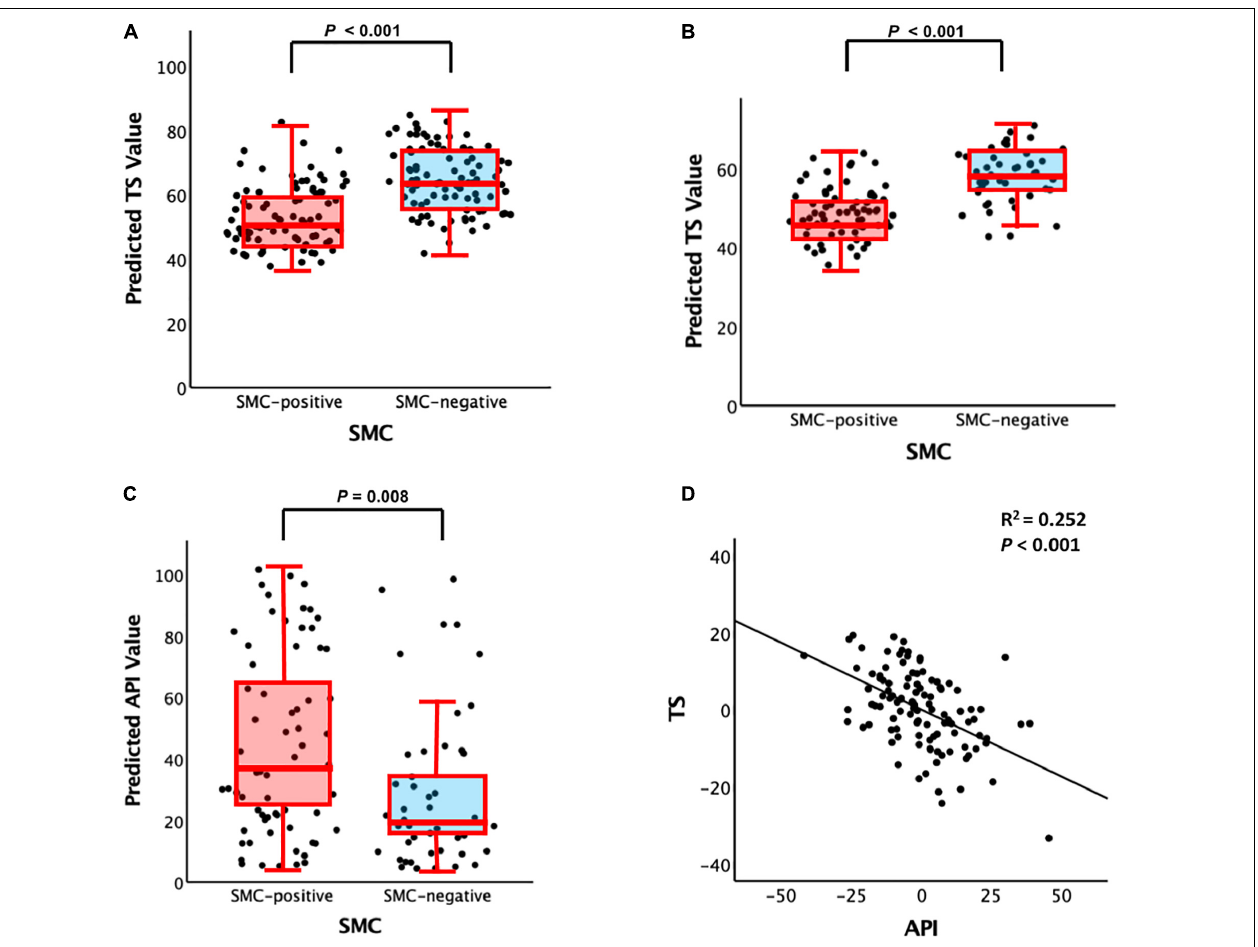
FIGURE 1 | Plots of the associations among SMC (i.e., SMCQ3), API, and TS: (A) SMC vs. TS for non-demented participants, (B) SMC vs. TS for participants with MCI, (C) SMC vs. API for participants with MCI, and (D) API vs. TS for participants with MCI. SMC, subjective memory complaint; API, amyloid prediction index; TS, total score of the Consortium to Establish a Registry for Alzheimer’s Disease neuropsychological battery; MCI, mild cognitive impairment. For panels (A–C) , box plot controlling for all potential covariates. For panel (D) , partial regression plot controlling for all potential covariates are presented.